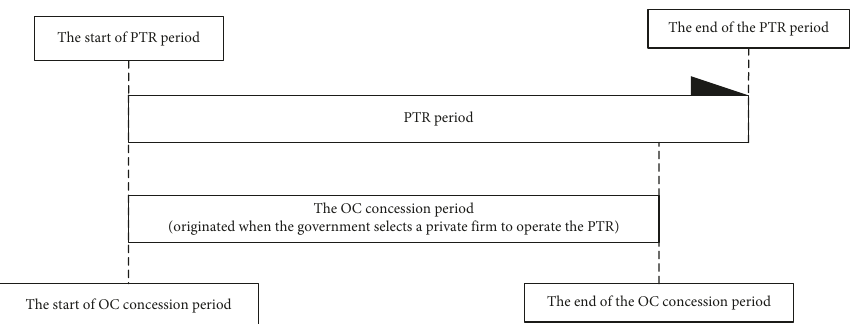
Figure 3: The relationship between OC concession period and PTR